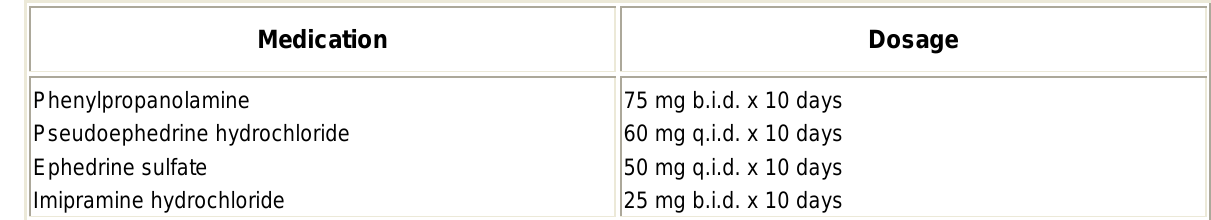
Pharmacologic Therapy for Retrograde